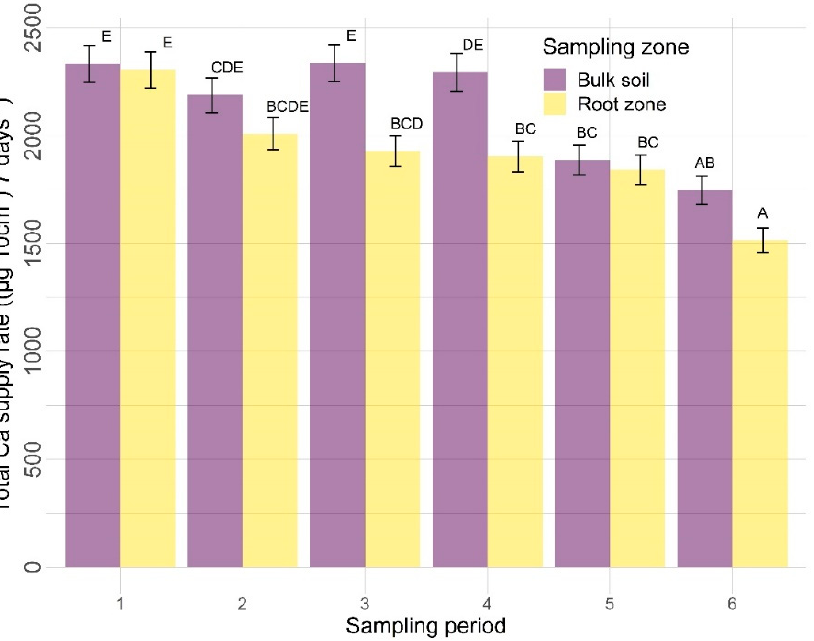
Figure 9. Ca supply rates as a function of sampling zone and time. Different letters indicate significance at p < 0.05 using the post hoc Tukey HSD test.